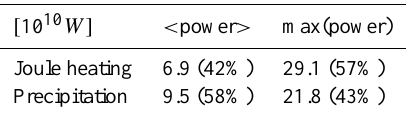
Table 1. Summary of the power dissipated into the ionosphere dur- ing the April 2000